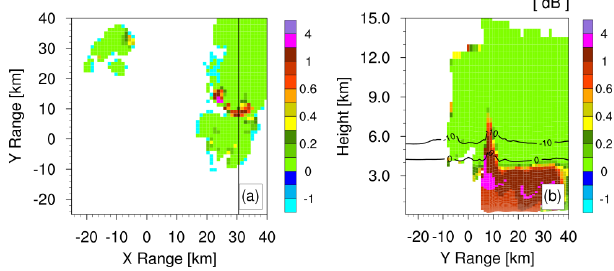
Figure 13. Plan view (a) and vertical cross section (b) of differen- tial reflectivity. The plan view is shown at 6km height, and the cross section is passing through the solid line shown in the plan view. The 0 and − 10 ◦ C isotherm are also shown in the cross